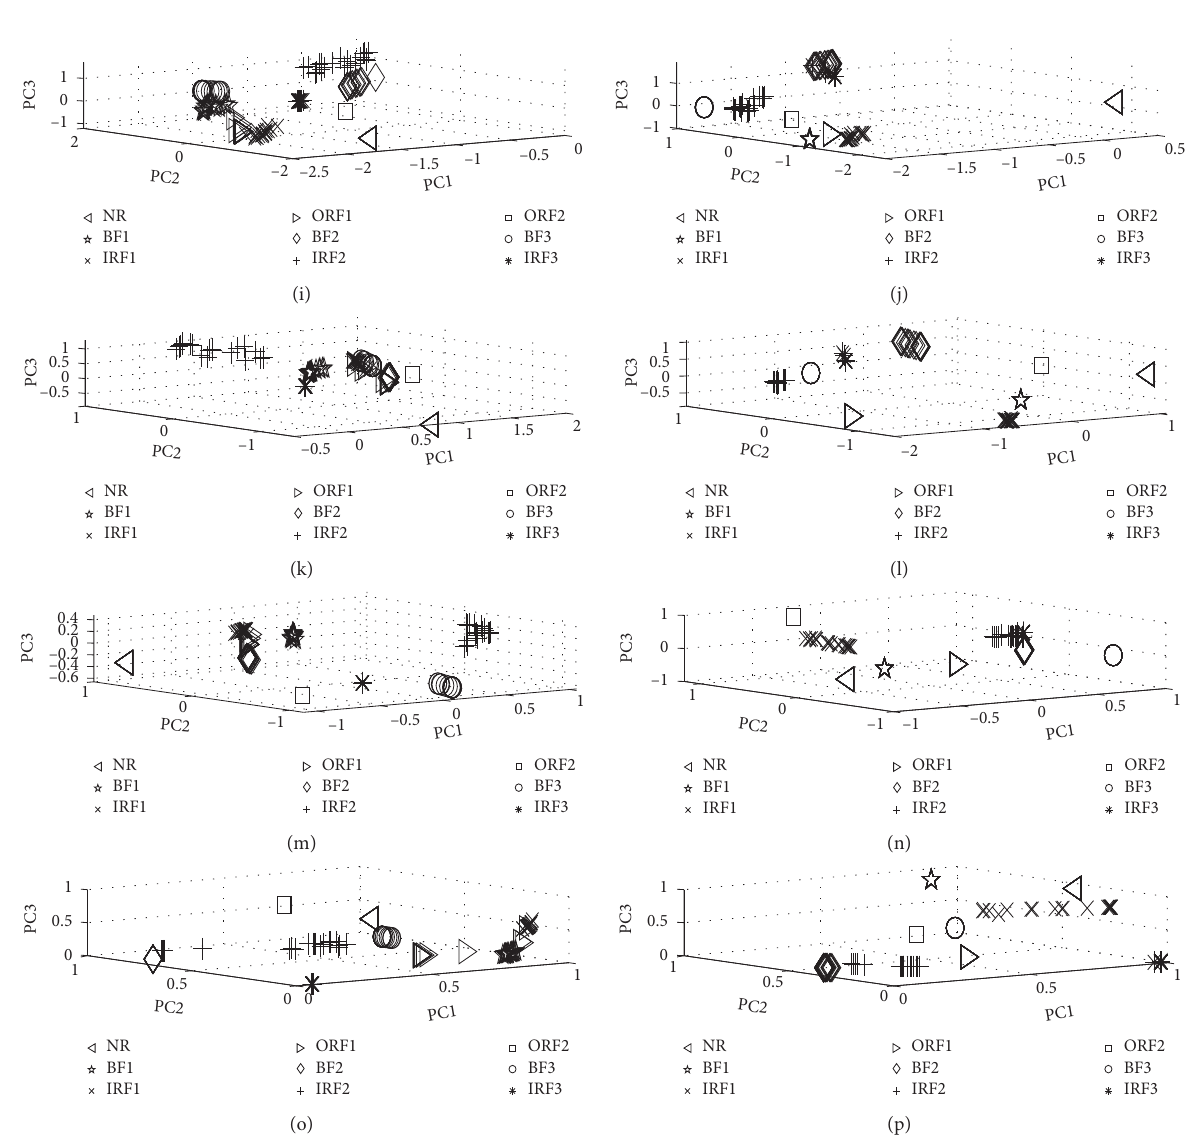
Figure 14: The 3-dimensional results of different datasets for the testing dataset through eight hidden layers by using an SDAE with PCA dimension reduction; 1–8 denote the hidden layer number. (a) SDAE-A-512-testing data. (b) SDAE-B-512-testing data. (c) SDAE-A-256- testing data. (d) SDAE-B-256-testing data. (e) SDAE-A-128-testing data. (f) SDAE-B-128-testing data. (g) SDAE-A-64-testing data. (h) SDAE-B-64-testing data. (i) SDAE-A-32-testing data. (j) SDAE-B-32-testing data. (k) SDAE-A-16-testing data. (l) SDAE-B-16-testing data. (m) SDAE-A-8-testing data. (n) SDAE-B-8-testing data. (o) SDAE-A-3-testing data. (p) SDAE-B-3-testing